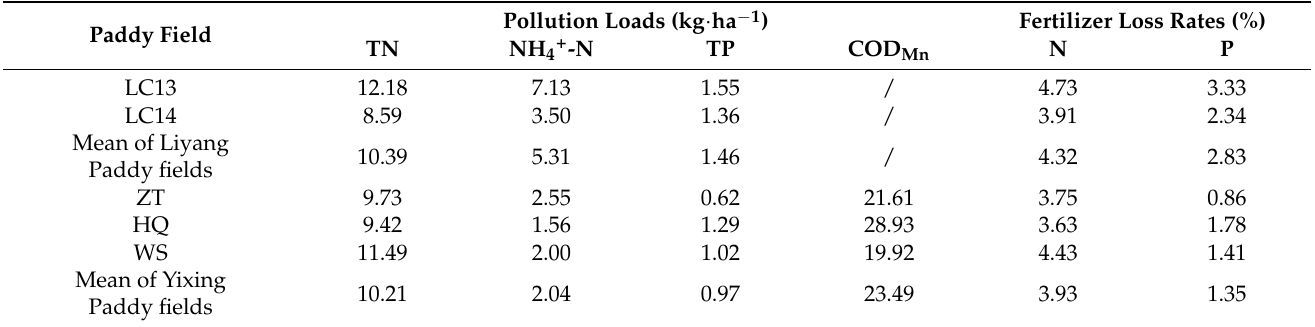
Table 2. Runoff TN, NH 4+ -N, TP and COD Mn loads and N and P fertilizer loss rates of the paddy